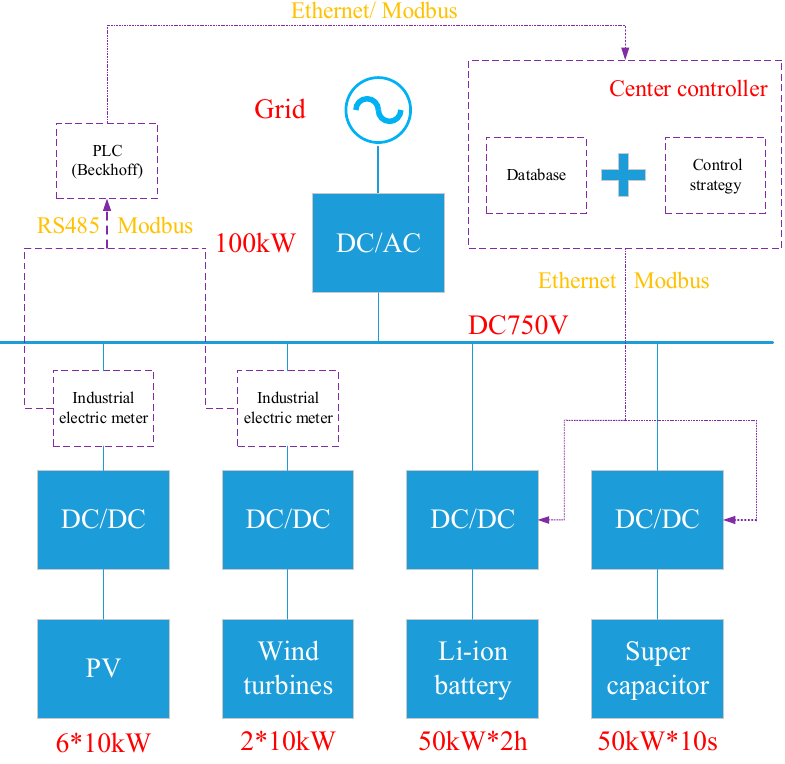
Figure 8. Microgrid system structure.